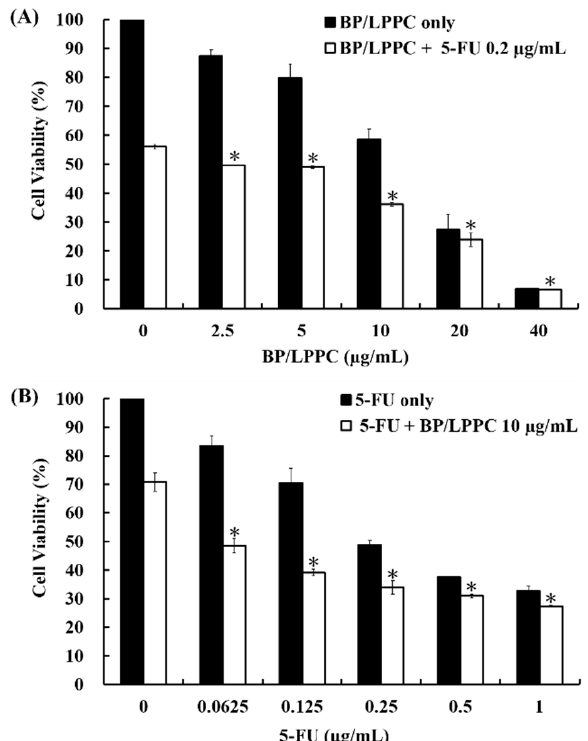
Figure 4. Combination of BP/LPPC and 5-FU revealed a synergistic effect on melanoma cells. The cells were treated with ( A ) BP/LPPC (0–40 µg/mL) combined with 5-FU (0.2 µg/mL); ( B ) 5-FU (0–1 µg/mL) combined with BP/LPPC (10 µg/mL). The cell viability was measured by MTT assay. * p < 0.05 versus control dose (0 µg/mL) in combination